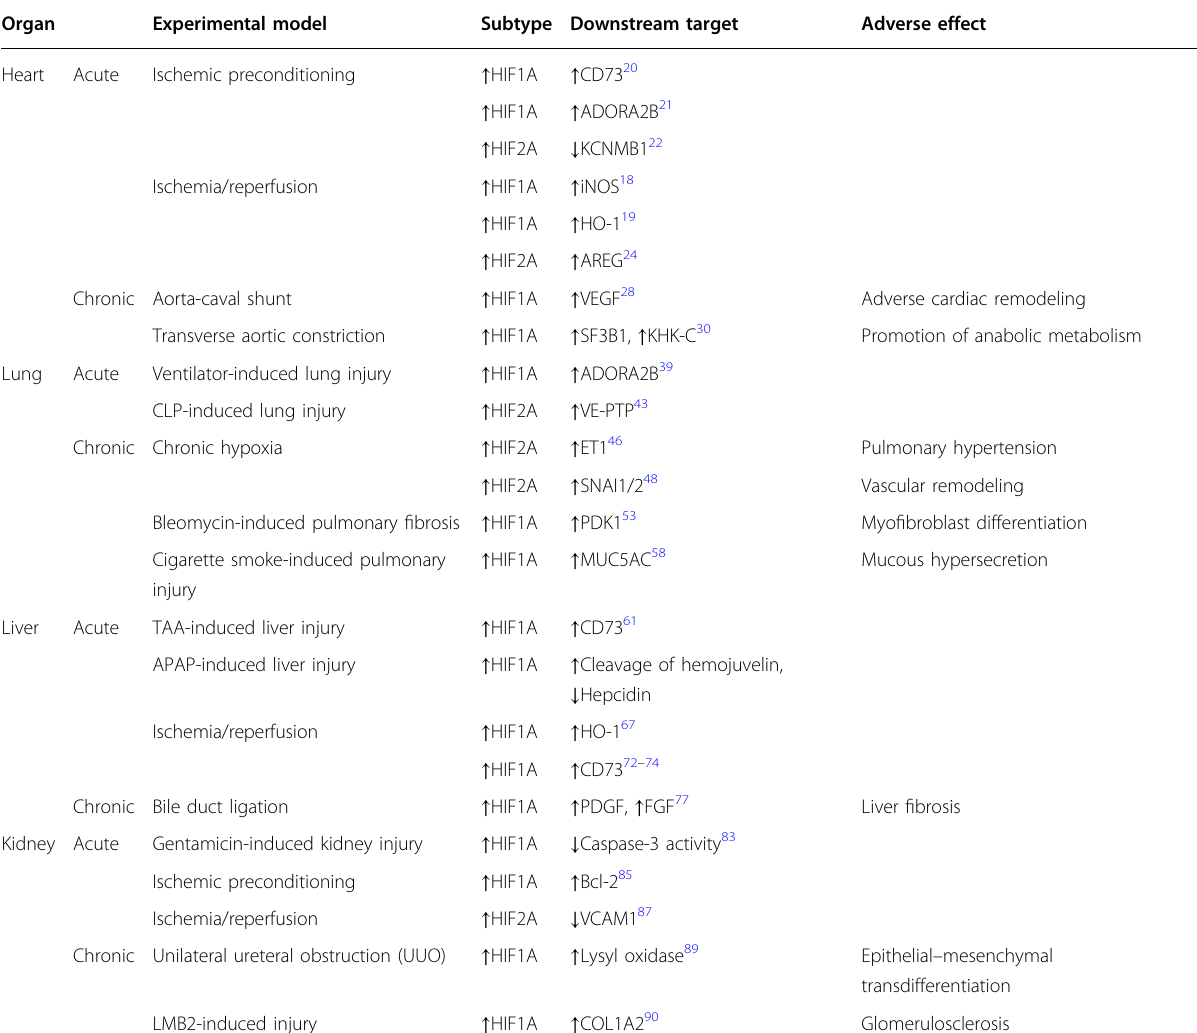
Table 1 HIF stabilization and its downstream targets in different organ systems